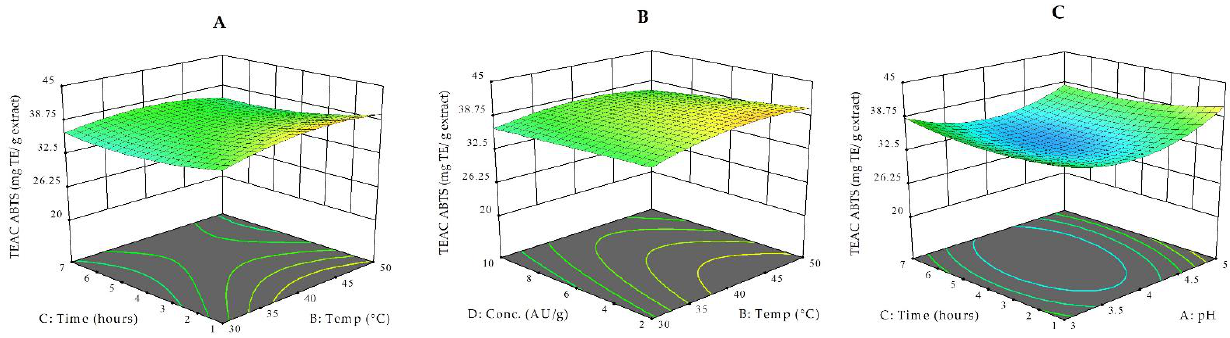
Figure 2. 3D response surface plots for TEAC ABTS as a function of temperature and time (at a constant enzyme concentration of 6 AU/g and at a pH of 4.5) ( A ), temperature and enzyme concentration (at a constant time of 2 h and at a pH of 4.5) ( B ), and extraction time and pH (at a constant temperature of 40 ◦ C and at an enzyme concentration of 6 AU/g) ( C ) Figure 3 presents the 3D response surface plots for TPC as a function of various in- dependent variables. The TPC was measured by the Folin – Ciocalteu assay, and the results were expressed as mg of GAE/g of extract. Similar to the TEAC ABTS, the highest TPC value (13.26 mg GAE/ g extract) was obtained under treatment at 50 °C and a pH of 5 (Table 1). The lowest TPC values were observed in the treatments performed at a pH of 4 and tem- perature of 40 °C (runs 2, 3, and 16, Table 1). The higher (10 AU/g pomace) and lower (2 AU/g pomace) enzyme concentration treatments resulted in quite similar values of TPC over an increasing period of extraction time, as also suggested by the lack of significance ( p = 0.13) in the interaction of these terms (Supplementary Materials, Table S1). Figure 3. 3D response surface plots for TPC as a function of temperature and pH (at a constant time of 4 h and at an enzyme concentration of 6 AU/g) ( A ), temperature and time (at a constant pH of 4 and at an enzyme concentration of 6 AU/g) ( B ), and extraction time and pH (at a constant temperature of 40 °C and at an enzyme concentration of 6 AU/g) ( C ). 3.2. Model Validation and Simultaneous Response Optimization by the Desirability Function The analysis of variance (ANOVA) was used to determine the adequacy of the developed models. ANOVA indicated that all the proposed models were significant ( p < 0.0001) with F-values of 46.12, 13.95, and 13.81 for RF I, II, and III, respectively (Supple- mentary Materials, Table S1). The models ’ adequacy, also depicted by the lack of fit F- values, showed that this parameter is not significant compared to the pure error ( p > 0.05), which is the desired characteristic (Supplementary Materials, Table S1). The determina- tion coefficients (R 2 ) are presented in Table S2 in the Supplementary Materials. However, since a sizeable R 2 value does not always indicate a sound regression model, attention should also be given to the adjusted and predicted R 2 values [32]. As presented in Table